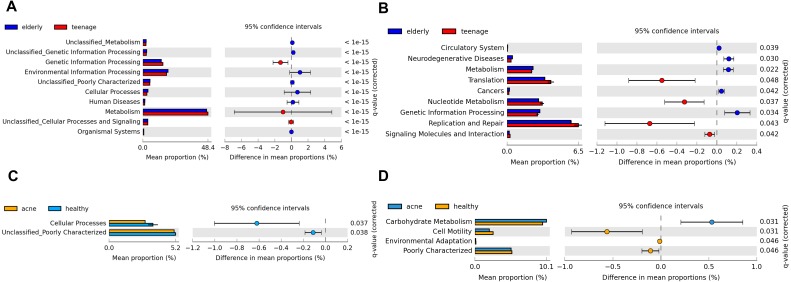
Potential metabolic functions in KEGG pathways (levels 1 and 2) between (A and B) the elderly.hea and teenage.hea and between (C and D) teenage.acn and teenage.hea.